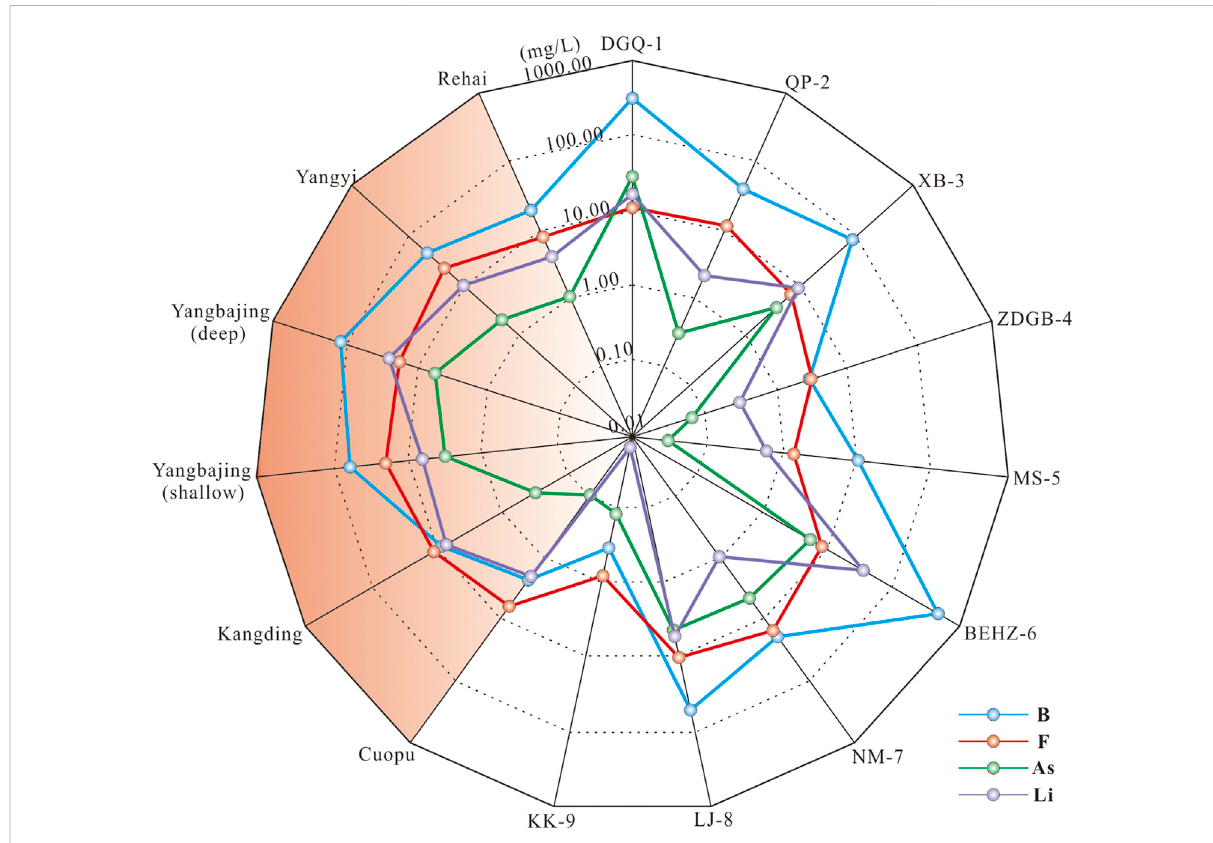
FIGURE 5 Concentrations of Li, B, F and As in geothermal waters along the KKF compared with those from typical high-temperature geothermal systems in the Himalayan geothermal belt (Guo et al., 2008, 2009; 2014; Wang,